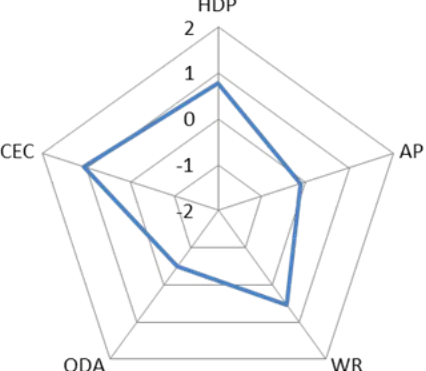
Fig. 5. Profile 1 – this profile corresponds to the most advanced countries having a relatively good human development (HDP) based on a diversified economy (AP) and political/democratic organiza- tion (CEC). WSS level is, therefore, relatively high compared to other developing countries; consequently, these countries benefit from low ODA from donors.